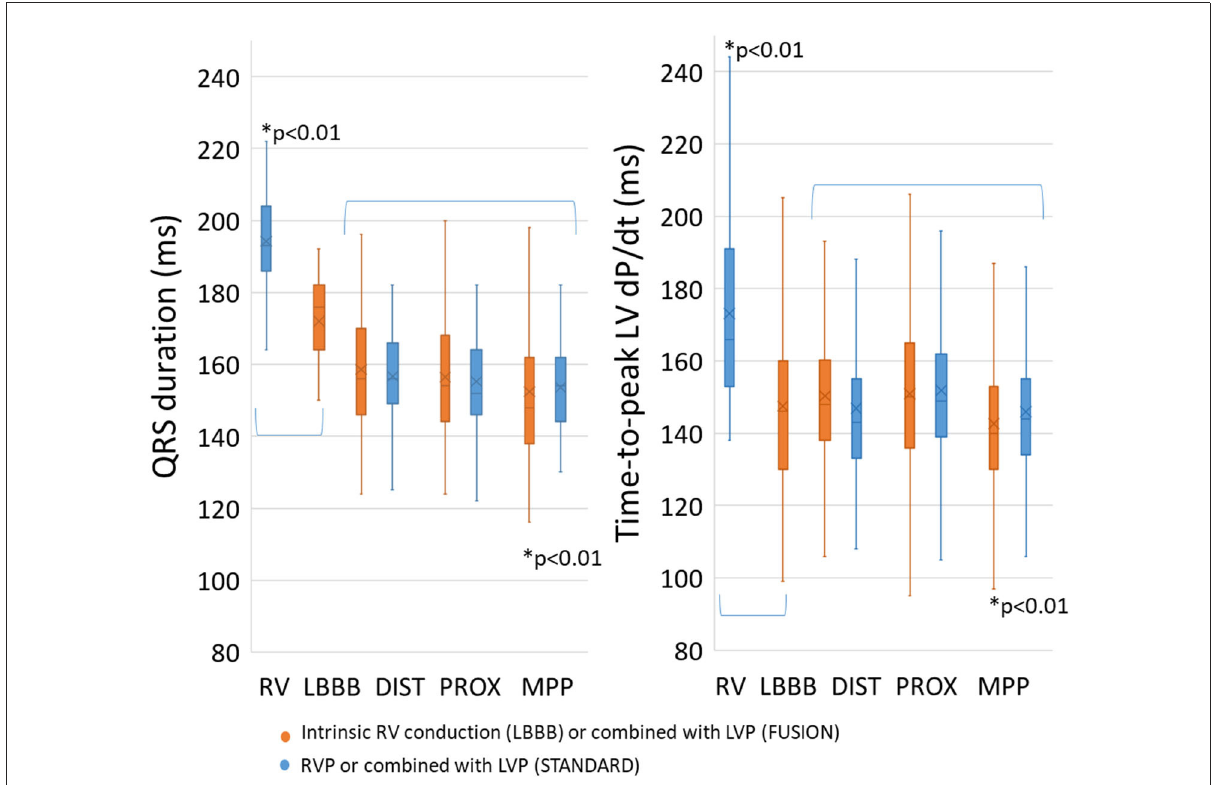
FIGURE1 Mode of pacing and fusion with intrinsic RV conduction. A significant increase was found for both QRS duration and time-to-peak dP/dt with RV pacing compared to baseline LBBB. Multipoint pacing with intrinsic RV conduction significantly shortened QRS duration and time-to-peak dP/dt compared to the others ( p < 0.01). RV, right ventricle; LBBB, left bundle-branch block; DIST, distal electrode; PROX, proximal electrode; MPP, multipoint pacing. * p < 0.01 compared to all